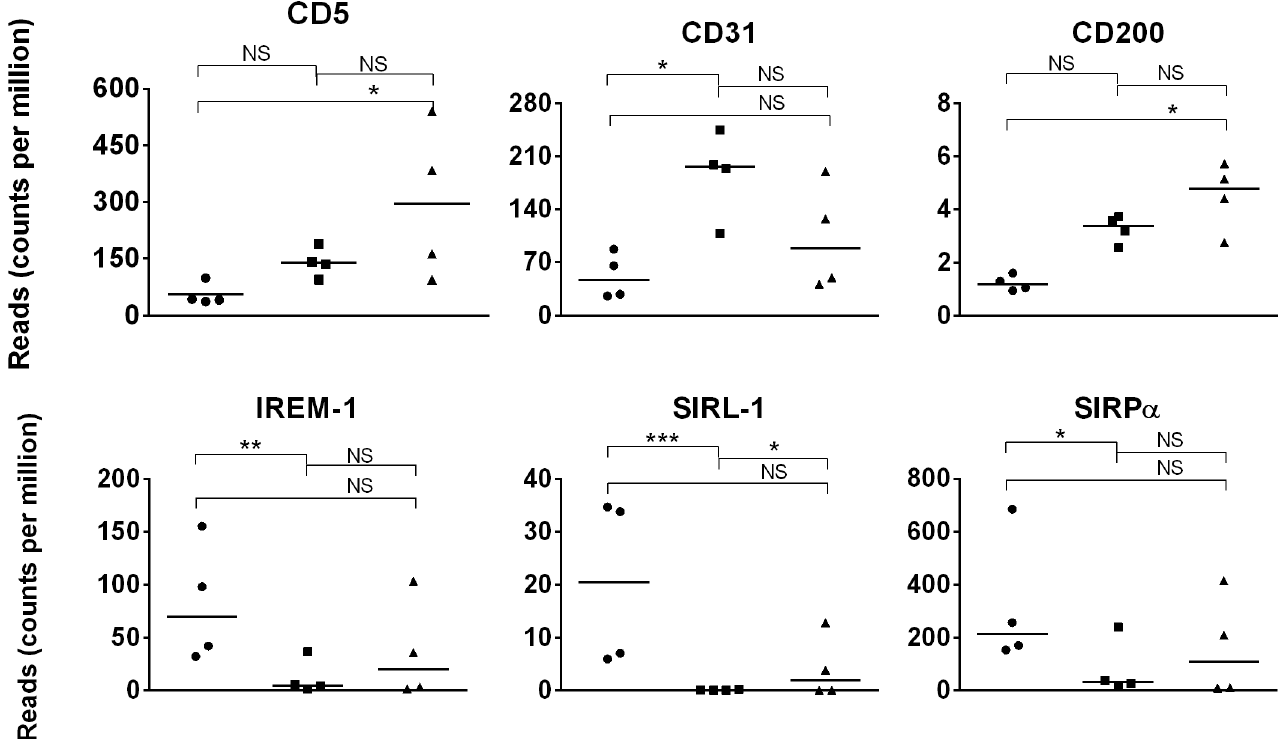
Fig 10. Inhibitory immune receptor gene expression in day 1 foal, day 42 foal, and adult horse samples. Expression (quantified by number of reads on y- axis) of inhibitory immune receptor genes in day 1 foal (circle), day 42 foal (square), and adult (triangle) samples are plotted on the x-axis. The significance level of comparisons is indicated by asterisks ( (cid:3) p < 0.05; (cid:3)(cid:3) p (cid:20) 0.001; (cid:3)(cid:3)(cid:3) p (cid:20) 0.0001); comparisons that did not differ statistically are labeled “NS” to denote not significant.